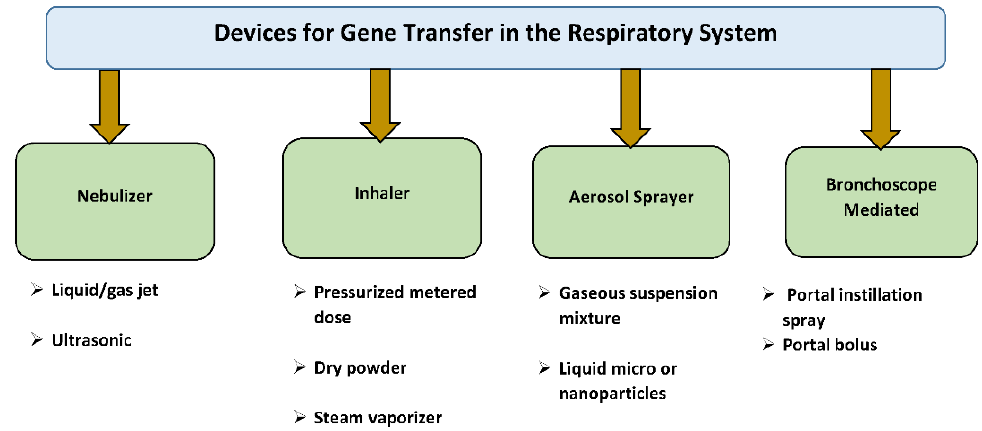
Figure 3. Devices for gene transfer in the respiratory system.